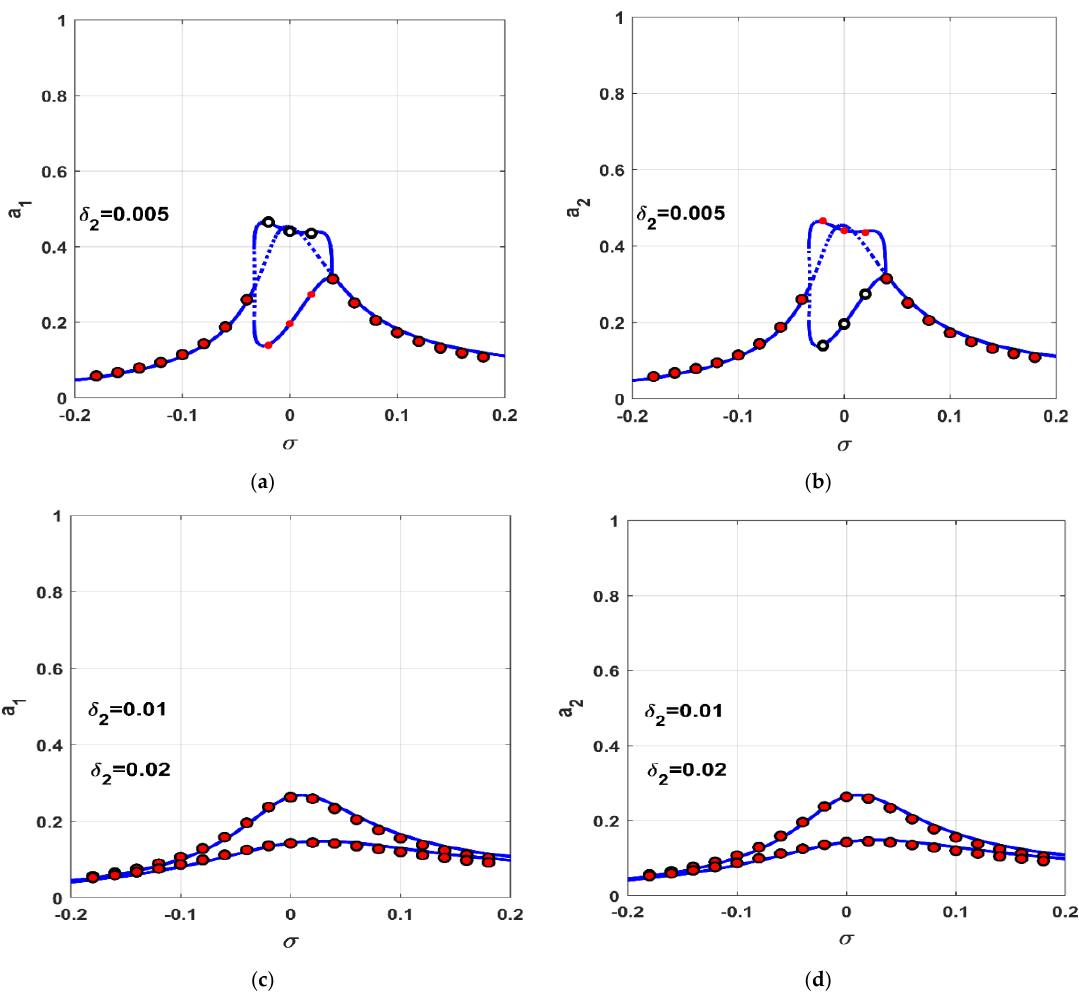
Figure 15. 𝜎 − response curve of the controlled Jeffcott rotor (i.e., 𝐸 = 0.03,𝜆 = 0.05 , and 𝛿 (cid:2869) = 0.83 ) Figure 15. σ —response curve of the controlled Jeffcott rotor (i.e., E = 0.03, λ = 0.05, and δ 1 = 0.83) at three different value of the derivative gain 𝛿 (cid:2870) : ( a , b ) oscillation amplitudes ( 𝑎 (cid:2869) and 𝑎 (cid:2870) ) versus 𝜎 at three different value of the derivative gain δ 2 : ( a , b ) oscillation amplitudes ( a 1 and a 2 ) versus σ when 𝛿 (cid:2870) = 0.005 , and ( c , d ) oscillation amplitudes ( 𝑎 (cid:2869) and 𝑎 (cid:2870) ) versus 𝜎 when 𝛿 (cid:2870) = 0.01,0.02 . when δ 2 = 0.005, and ( c , d ) oscillation amplitudes ( a 1 and a 2 ) versus σ when δ 2 = 0.01,